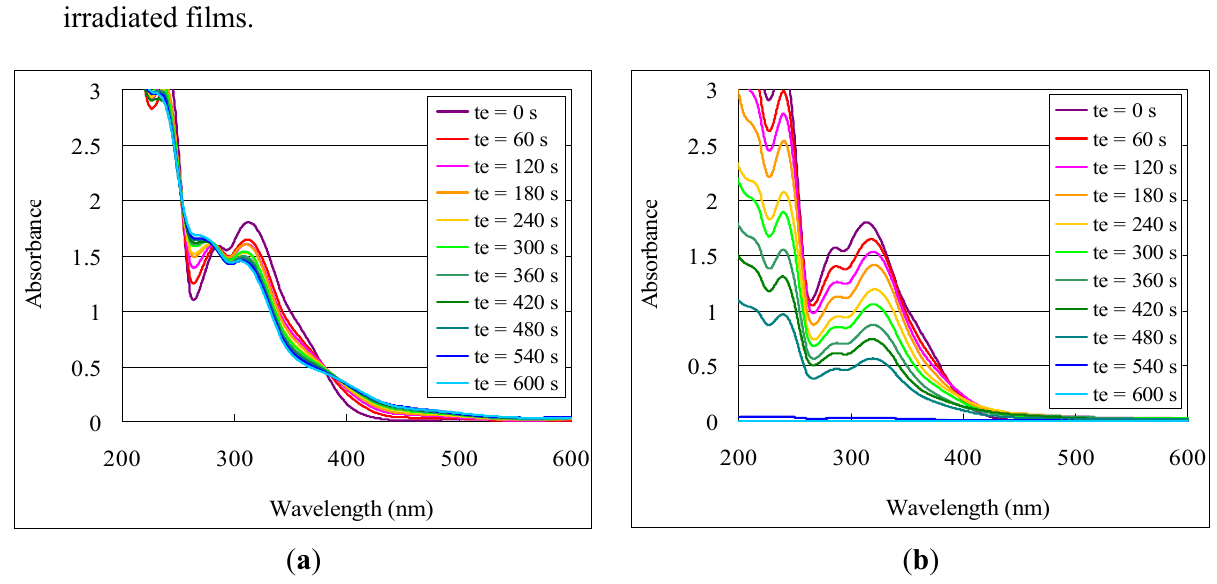
; and ( b ) after developing the e